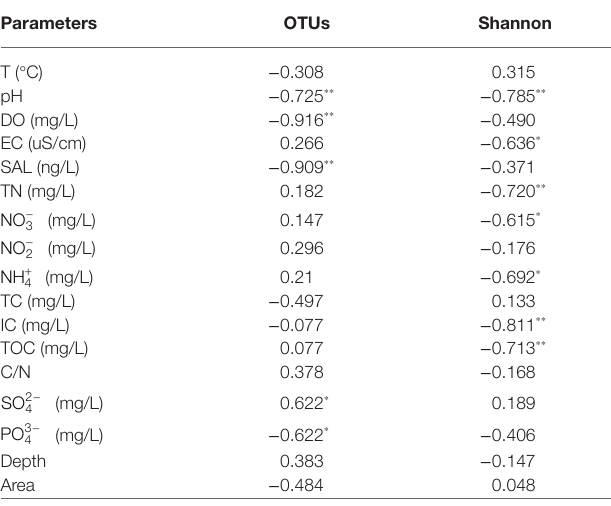
TABLE 3 | The Spearman correlations between environmental factors and alpha diversity of bacterial communities.